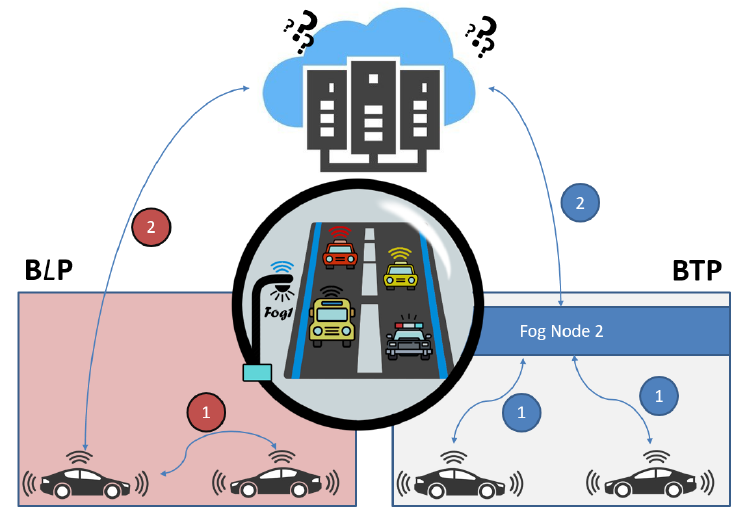
Figure 23. Blind Approach with Transport